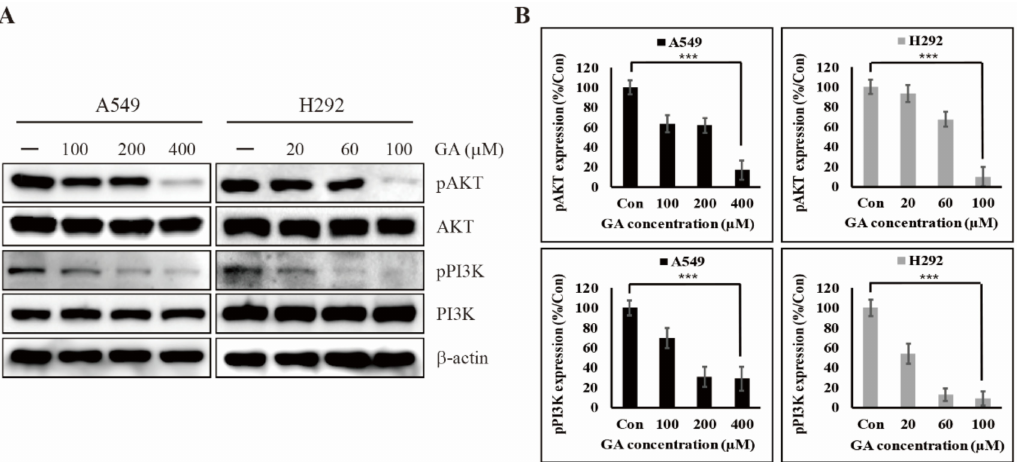
Figure 3. GA inhibits the phosphorylation of AKT and PI3K protein in a GA concentration-dependent manner. ( A ) The expression levels of pAKT and pPI3K protein in A549 and H292 cells were detected after GA treatment in concentrations indicated for 48 hours. ( B ) The relative expression levels of pAKT and pPI3K protein were determined by densitometry and normalized to β -actin. Data are representative of three independent experiments. *** p < 0.001 ( t-